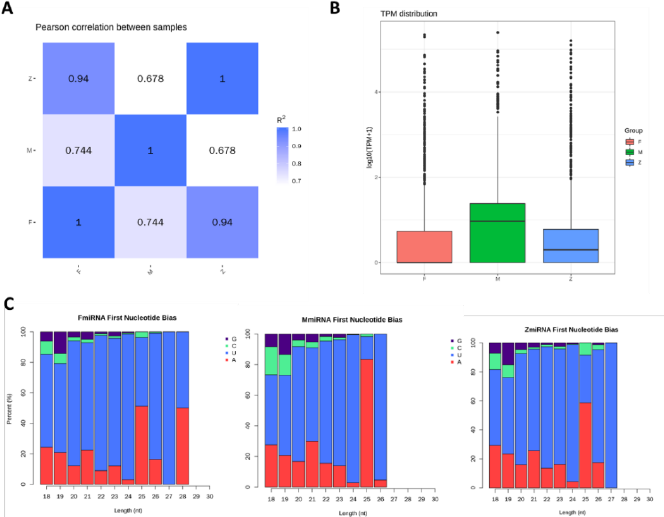
Figure 3. The microRNAs identified by males, females, and pseudo-females: ( A ) Correlation of miRNAs expression levels between samples. ( B ) The TPM distribution of males, females, and pseudo-females (F, M, Z). ( C ) The miRNAs first nucleotide bias of males, females, and pseudo-females (F, M, Z). 3.4. Differential miRNAs Analysis of Males, Females and Pseudo-Females (F, M and Z)